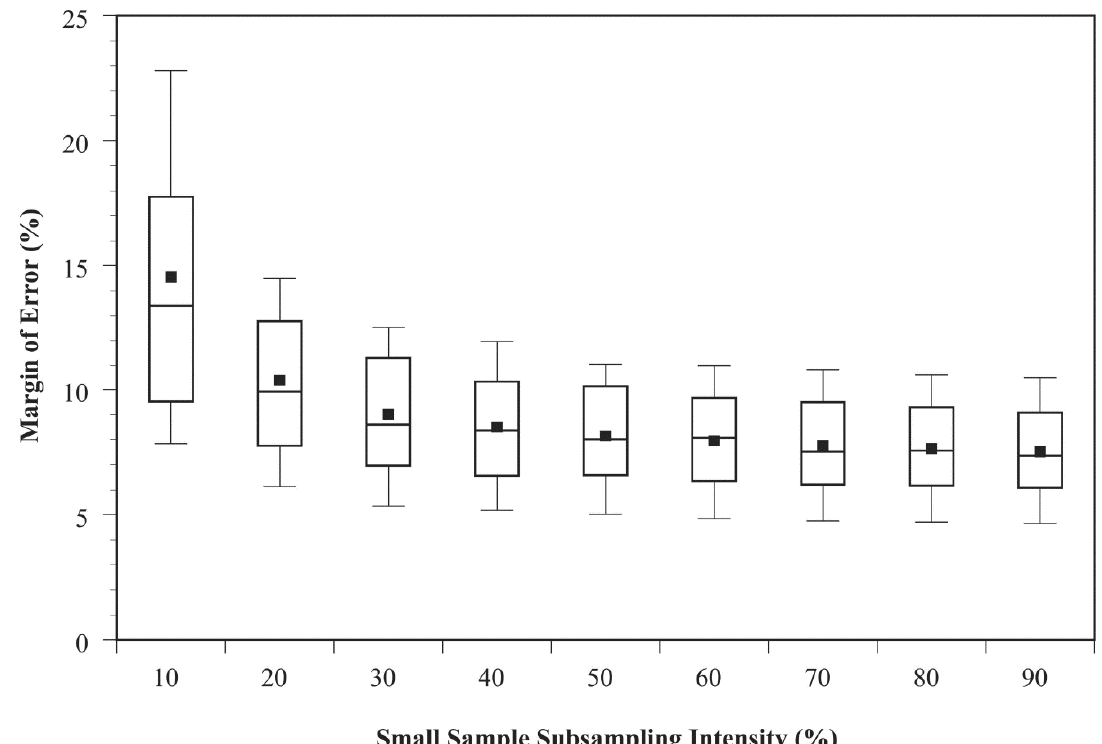
Figure 1. Distribution of percent margin of error (aboveground tree biomass) among 40 properties using a double sample design with different intensities of small sample subsampling from the large